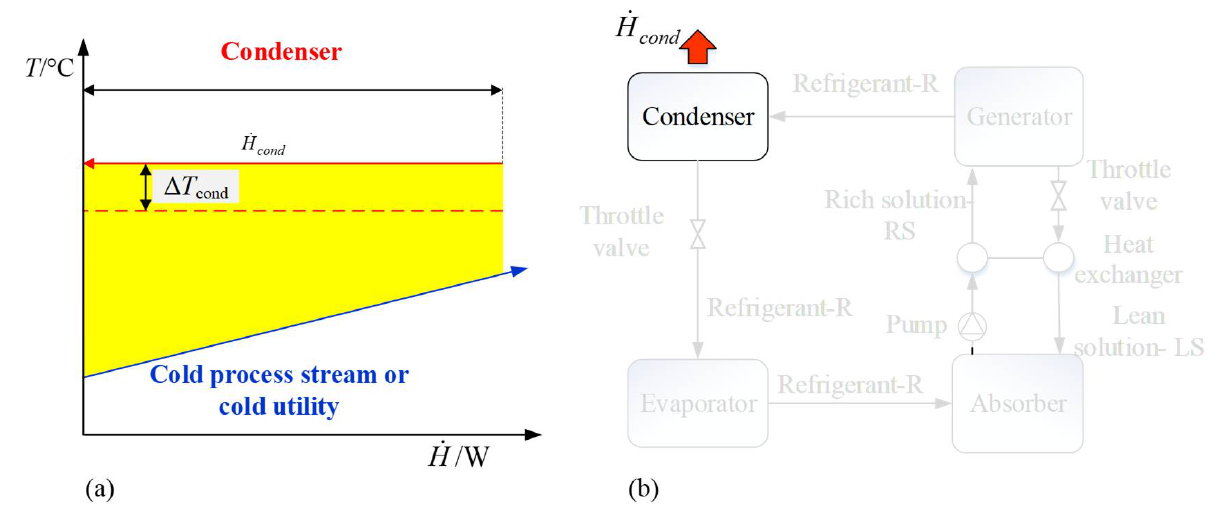
Figure 6. ( a ) Heat integration of a condenser by a composite curve and ( b ) presentation of condenser as a part of AC cycle.